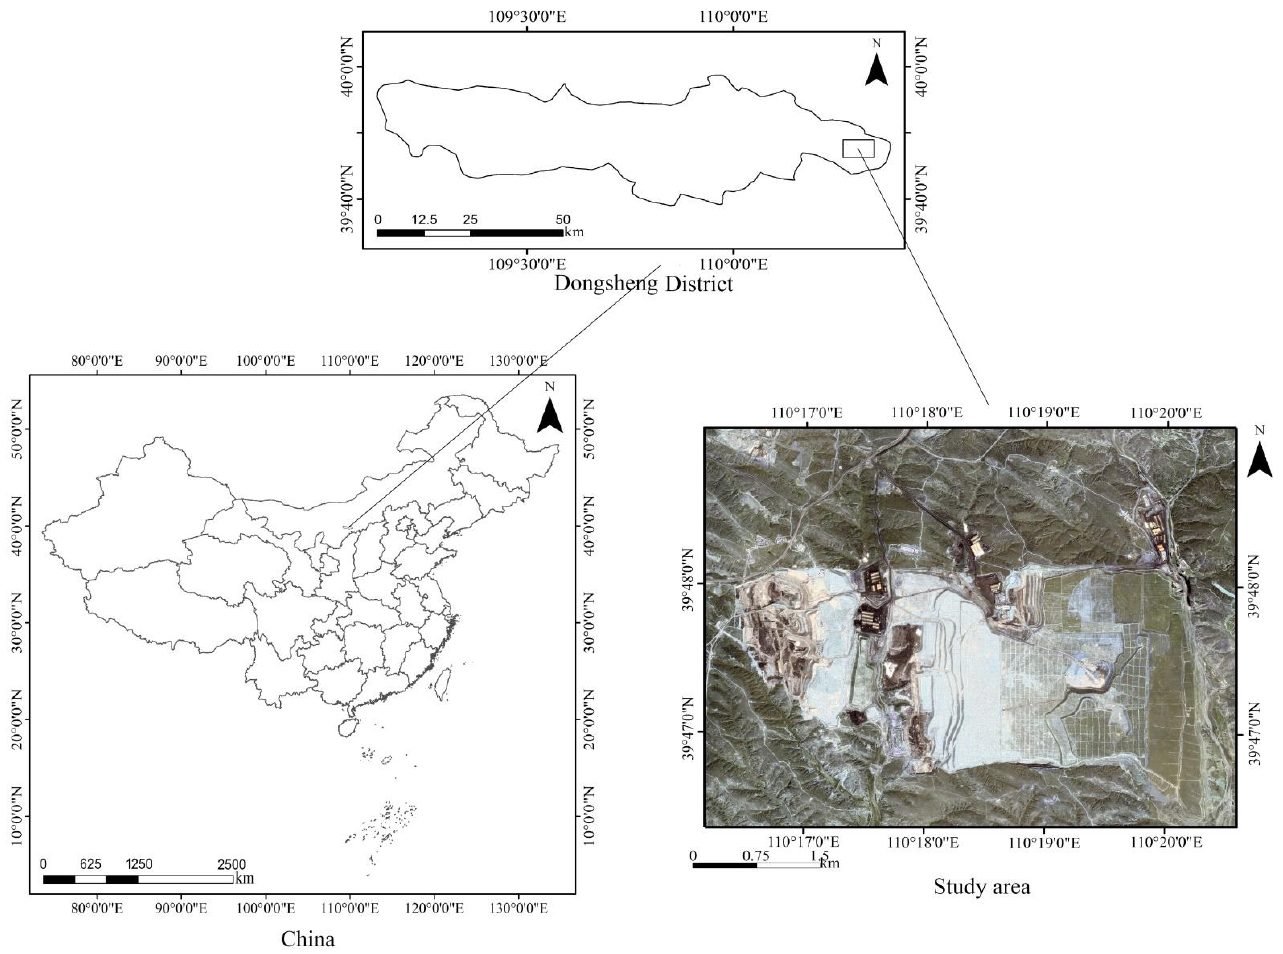
Figure 1. Image of the Bayin Mengkenayuan coal mine in Dongsheng District, Erdos City, Inner Mongolia of China (at 0.23 m, true color, Google Earth image in August 2019).